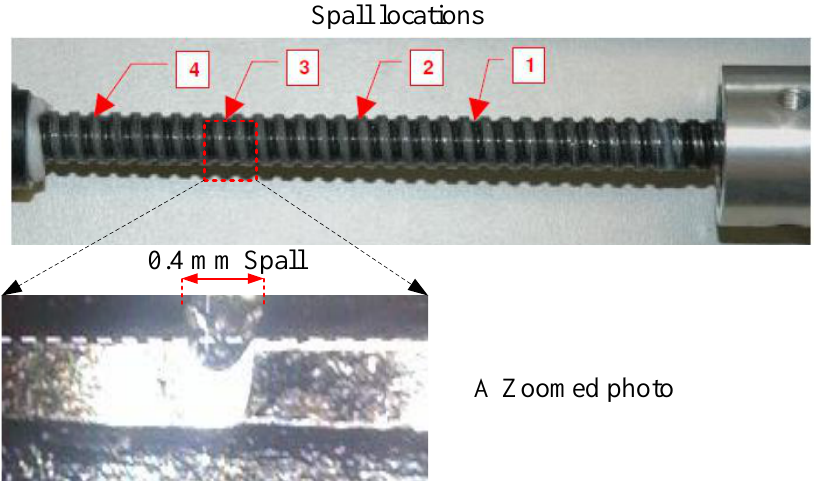
Figure 8. Spall injection on EMA’s ball-screw. Table 2. Spall injection locations. Table 1. Ball-screw geometry data.